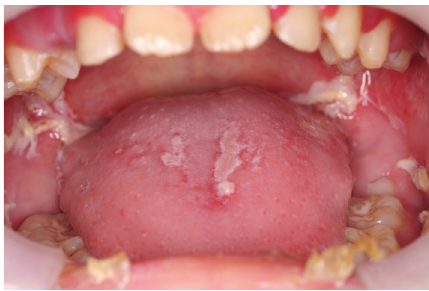
Figure 3: Generalized mucositis in a patient with acute myeloid